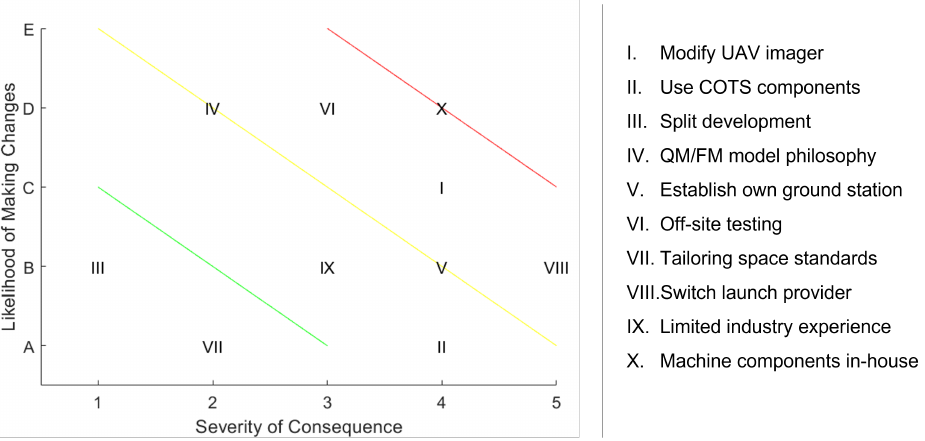
Figure 17. Mapped risks from the HYPSO-1 project; increasing impact toward the upper